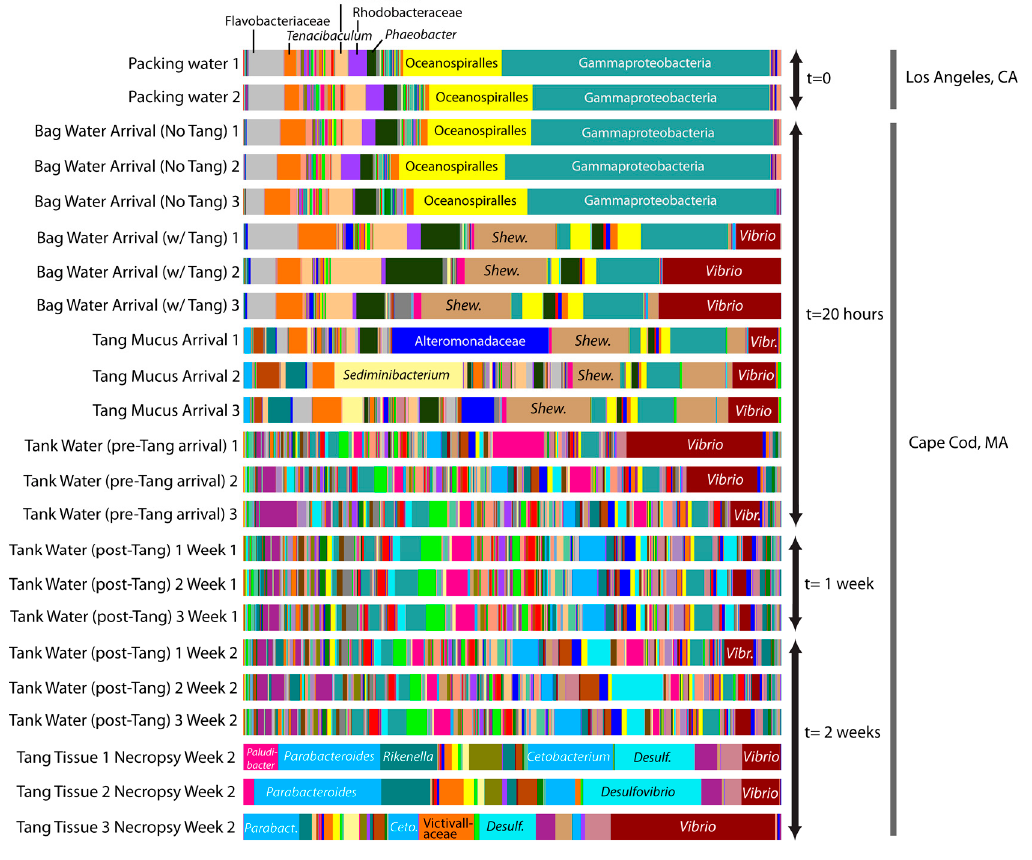
Figure 1. Bar graphs depicting relative changes in Operational Taxonomic Unit (OTU) composition at the genus level based on V6–V4 rRNA gene amplicon sequencing of samples associated with the shipment of Sailfin Tang ( Zebrasoma desjardinii ) collected along a U.S. leg of an international ornamental fish supply chain (Los Angeles distributor’s facility to Massachusetts pet shop). Vibrio genera are highlighted and labeled in red. Shewanella genera are highlighted and labeled in tan. Other dominant taxa are indicated as shown. Please see Figure S1 for a complete legend of OTU-assigned taxonomy.